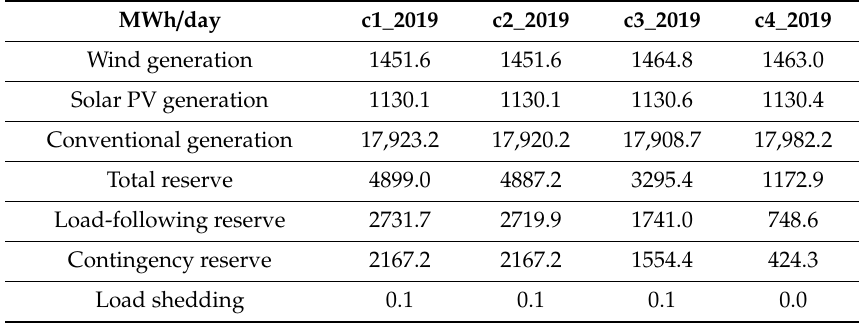
Table 4. Daily generation and reserve for a summer peak day in